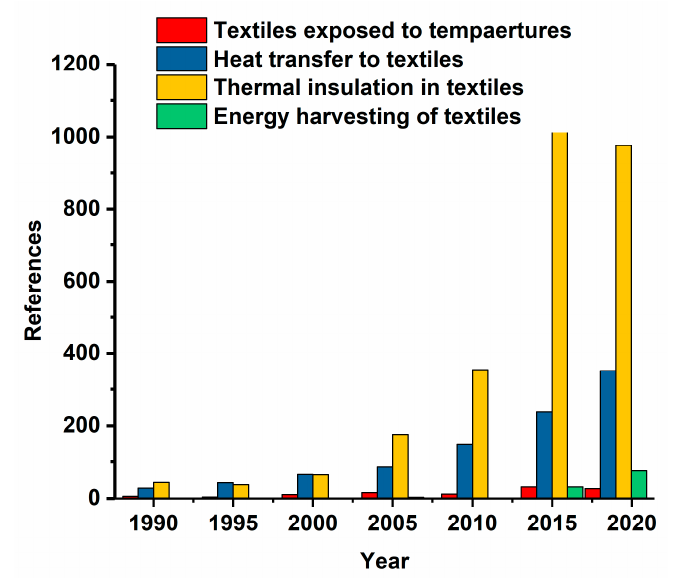
Figure 10. Temperature measurement in textiles and their use for energy generation.